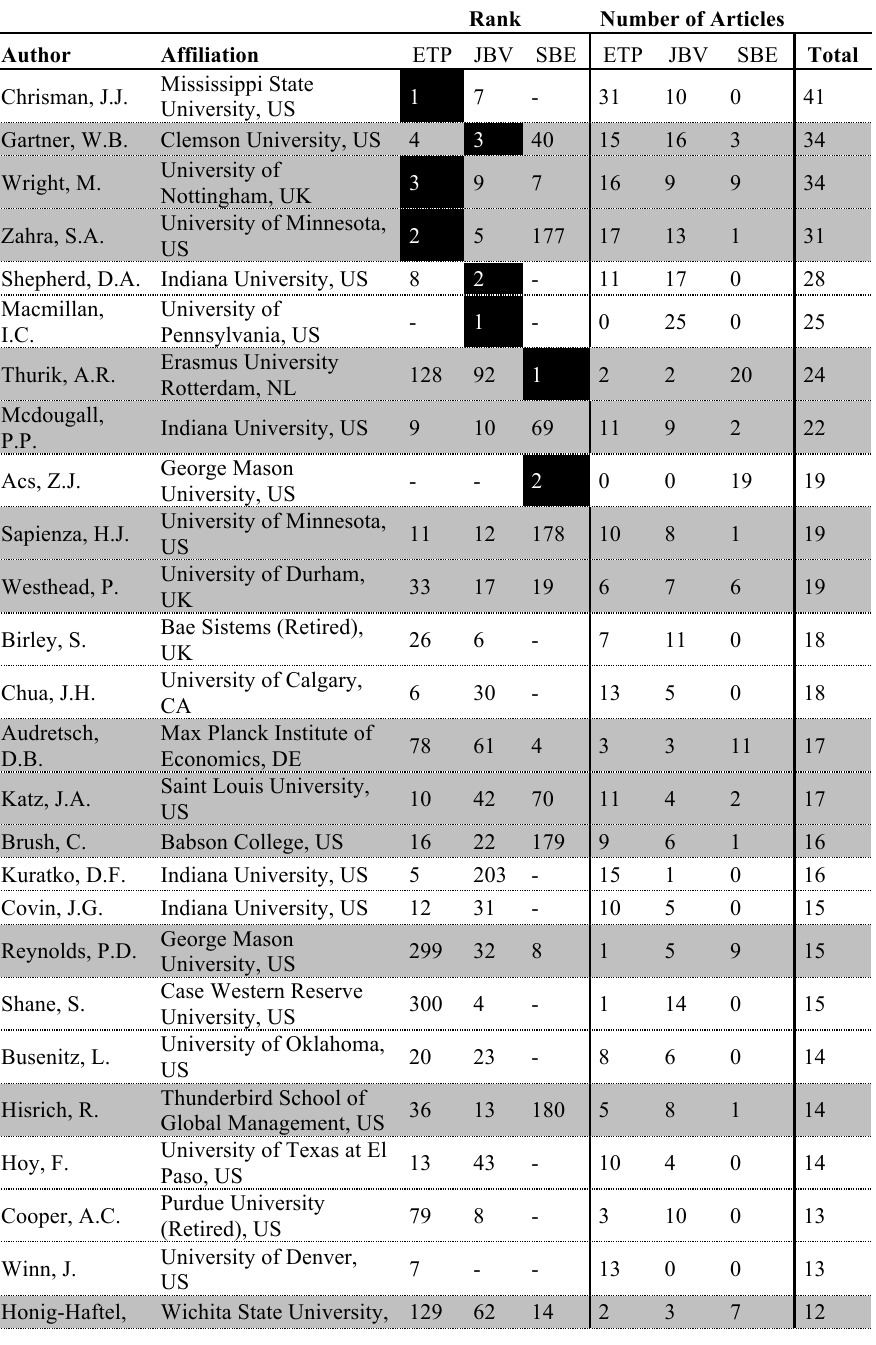
Rank Number of Articles